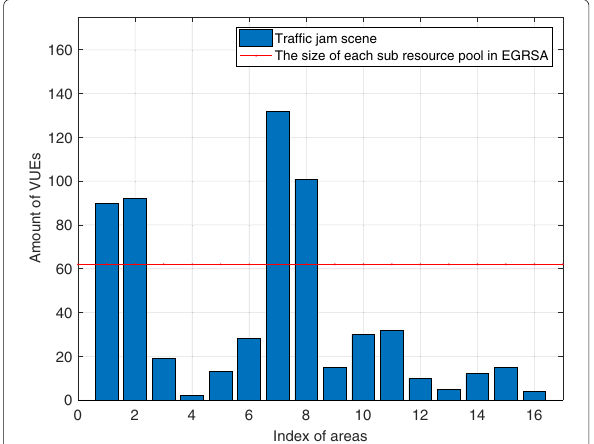
Fig. 14 Calculation of the amount of VUEs in every geographic area in the traffic jam scene. The red line in this figure represents the size of each sub resource pool when sub resource pools are divided equally just like in enhanced geo-based resource selection algorithm (EGRSA)